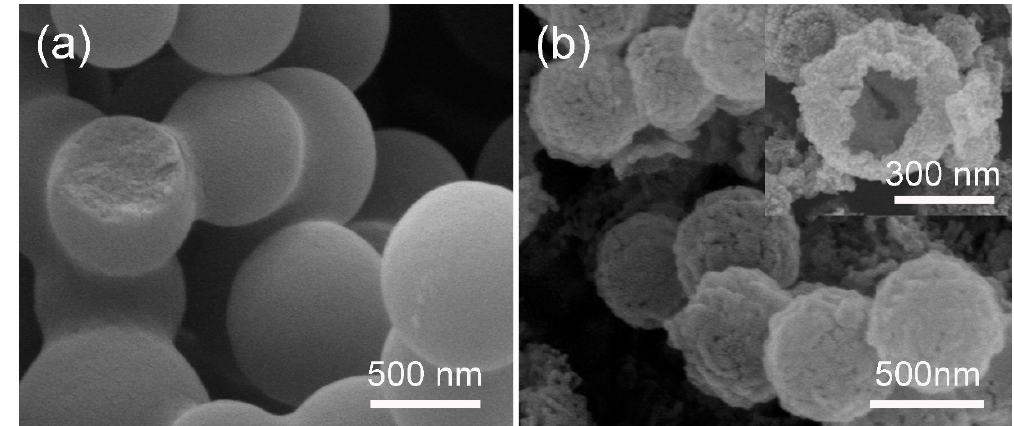
Figure 2. ( a ) SEM image of carbonaceous spheres template with size of ~600 nm; ( b ) ZnO hollow spheres (HS) obtained by soaking carbonaceous spheres in a 1 M zinc nitrate solution; the inset is the SEM of a broken ZnO HS.